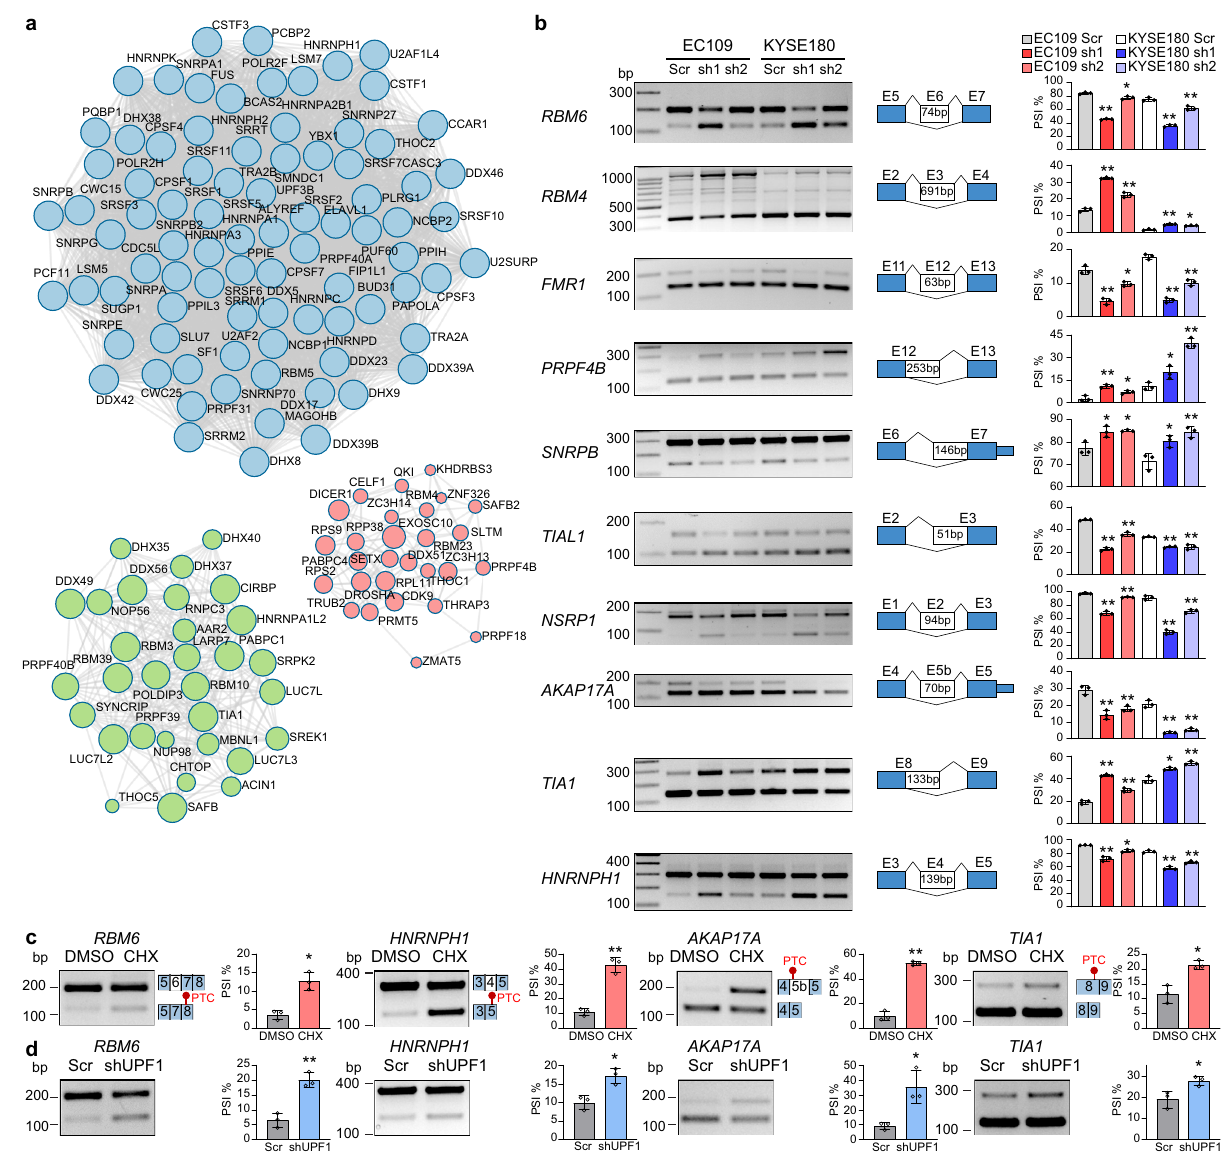
Fig. 4 DAP3 orchestrates splicing regulatory networks by modulating alternative splicing of splicing factors. a Functional protein association networks of genes that are involved in mRNA processing and have their splicing modulated by DAP3 were identi fi ed in Metascape 45 (http://metascape.org). b Semiquantitative RT-PCR analyses of splicing changes of 10 representative splicing factors RBM6, RBM4, FMR1, PRPF4B, SNRPB, TIAL1 , NSRP1, AKAP17A, TIA1 , and HNRNPH1 upon DAP3 depletion in EC109 and KYSE180 cells. c , d Semiquantitative RT-PCR analyses of splicing changes of RBM6, HNRNPH1, AKAP17A , and TIA1 upon inhibition of NMD in EC109 cells. Cells were treated with CHX or vehicle control (DMSO) for 6 h ( c ) or transfected shUPF1 or the scramble control (Scr) for 48 h ( d ). b – d Data are represented as mean ± s.d. of n = 3 biologically independent samples. Statistical signi fi cance is determined by unpaired, two-tailed Student ’ s t -test (* p < 0.05, ** p < 0.01). Exact p-values and source data are provided in Source Data fi